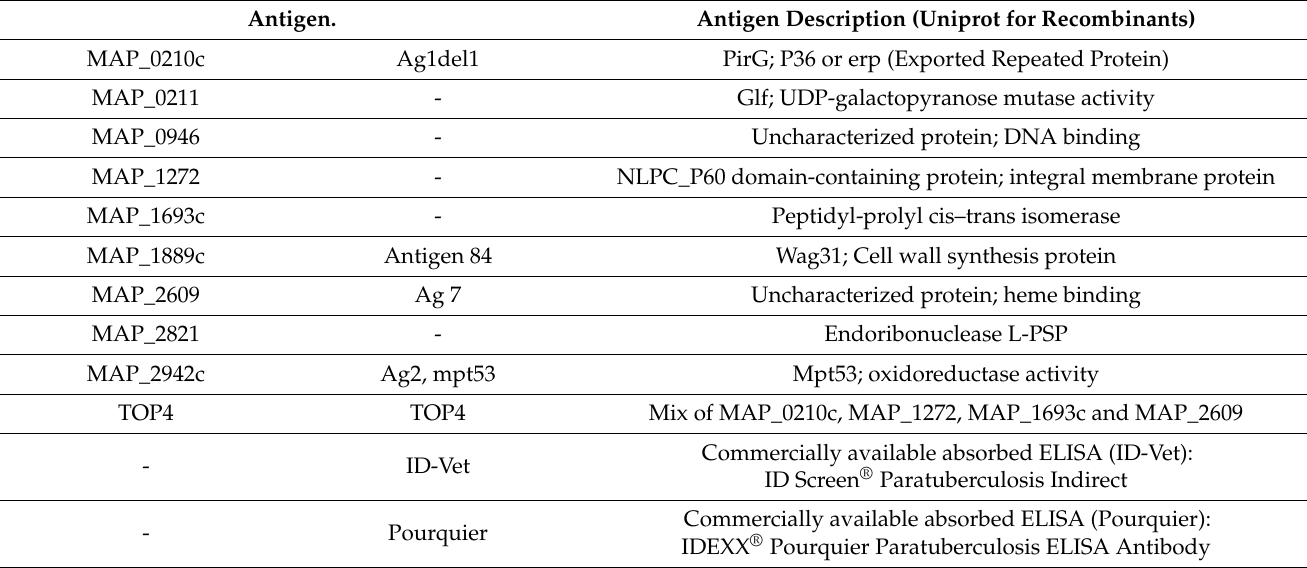
Table 2. Details of recombinant MAP antigens, antigen mixes and commercially available ELISA tests.